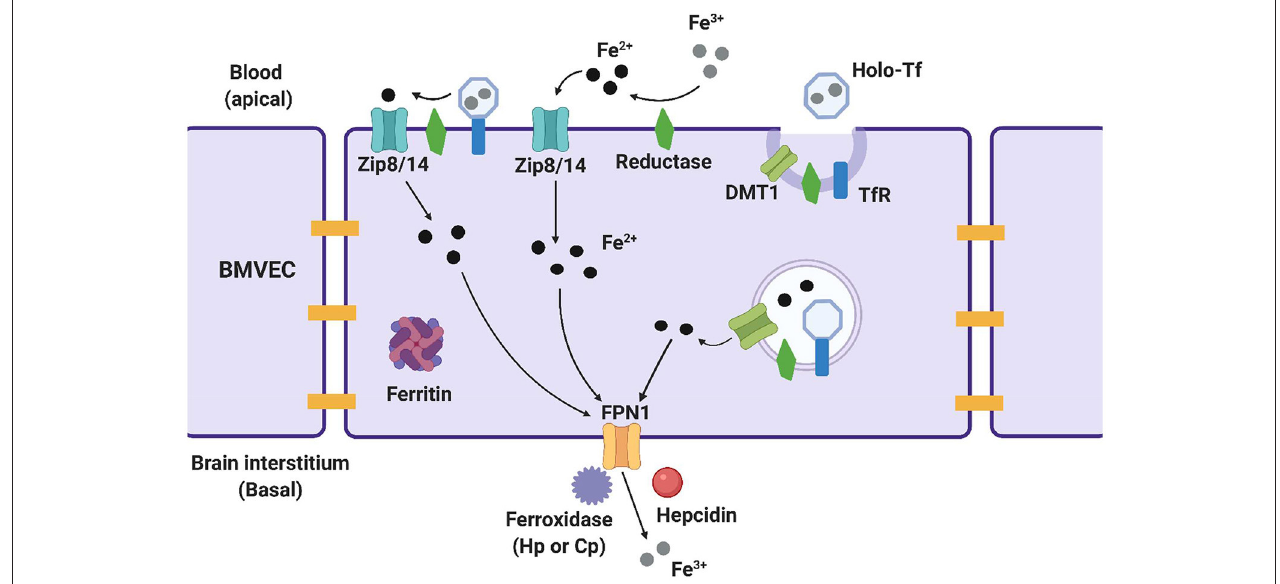
FIGURE 1 | Methods of iron trafficking in BMVECs. This image highlights the uptake and efflux pathways used for iron transport in BMVECs. The yellow bars represent tight junctions which will be discussed in a later section. ZIP8/14 can transport transferrin bound iron (TBI) and non-transferrin bound iron (NTBI), with the help of a reductase which reduces the iron and allows it to enter the cell. Ferric (Fe 3 + ) iron binds to transferrin, creating holo-Tf which binds to TfR and is endocytosed into an endolysosome in the cell. Here, the iron is reduced and leaves the endolysosome through DMT1. Within the cell, ferrous iron (Fe 2 + ) can be stored in ferritin for later use. When the iron is ready to exit the cell, it is first oxidized back to ferric iron by a ferroxidase, and exits through ferroportin (FPN). Hepcidin is an effector hormone known to induce degradation of ferroportin and prevent cellular iron efflux. This image was created with